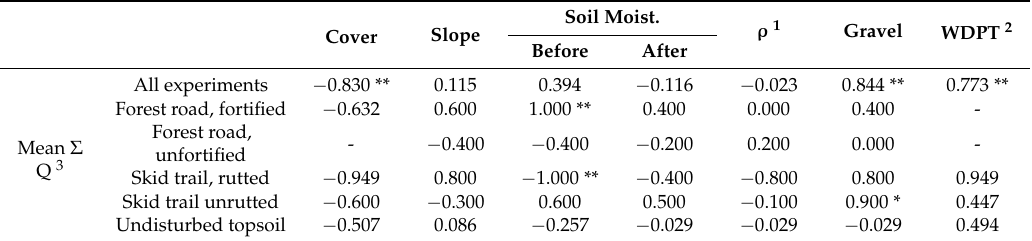
Table 7. Spearman-Rho correlations between mean runoff volumes and plot chracteristics. Soil Moist. ρ 1 Gravel WDPT 2 Cover Slope Before After All experiments ´ 0.830 ** 0.115 0.394 ´ 0.116 ´ 0.023 Mean Σ Q 3 Skid trail, rutted ´ 0.949 0.800 ´ 1.000 ** ´ 0.800 ´ 0.600 ´